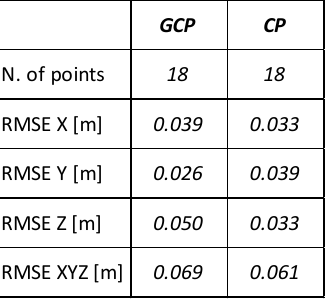
Table 2. RMSE of GCP and CP residuals.